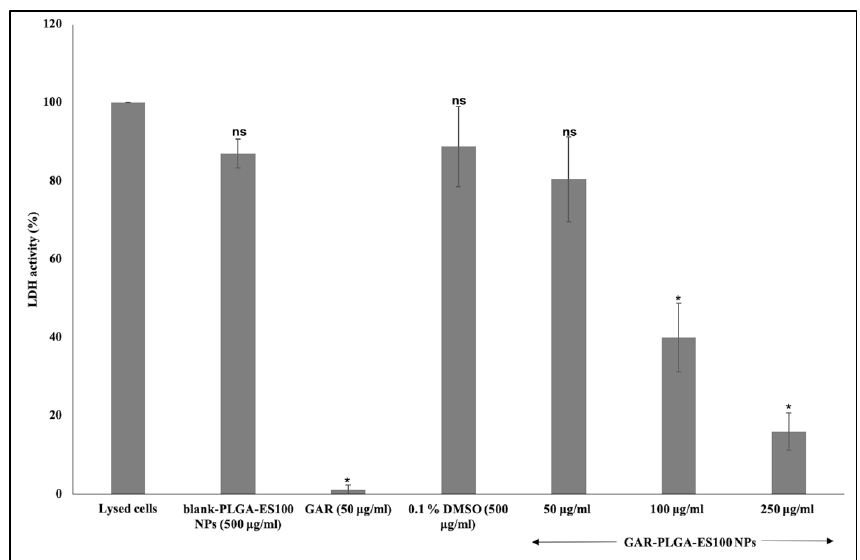
Figure 6. Lactate dehydrogenase (LDH) assay on CACO-2 cells treated for 24 h with blank-PLGA- ES100 NPs. Concentration was 500 μg/mL, free GAR was 50 μg/mL and GAR-PLGA-ES100 NPs (50, 100, and 250 μg/mL). Student’s unpaired t-test was carried out to check the statistical significance of the experiment (ns: not significant; * p < 0.05).